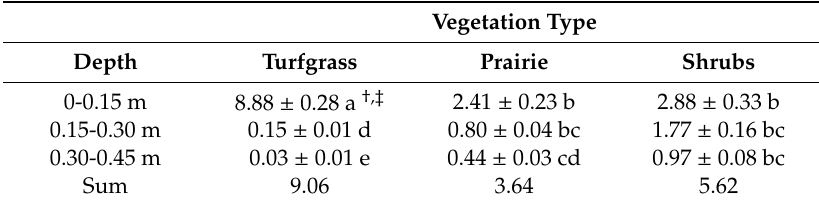
Table 4. Root mass density (kg m − 3 ) in soil cores by vegetation type. Data are the averages from three soil cores per depth. Di ff erences in root mass density among the three vegetation types depended on depth (Vegetation × Depth, p <